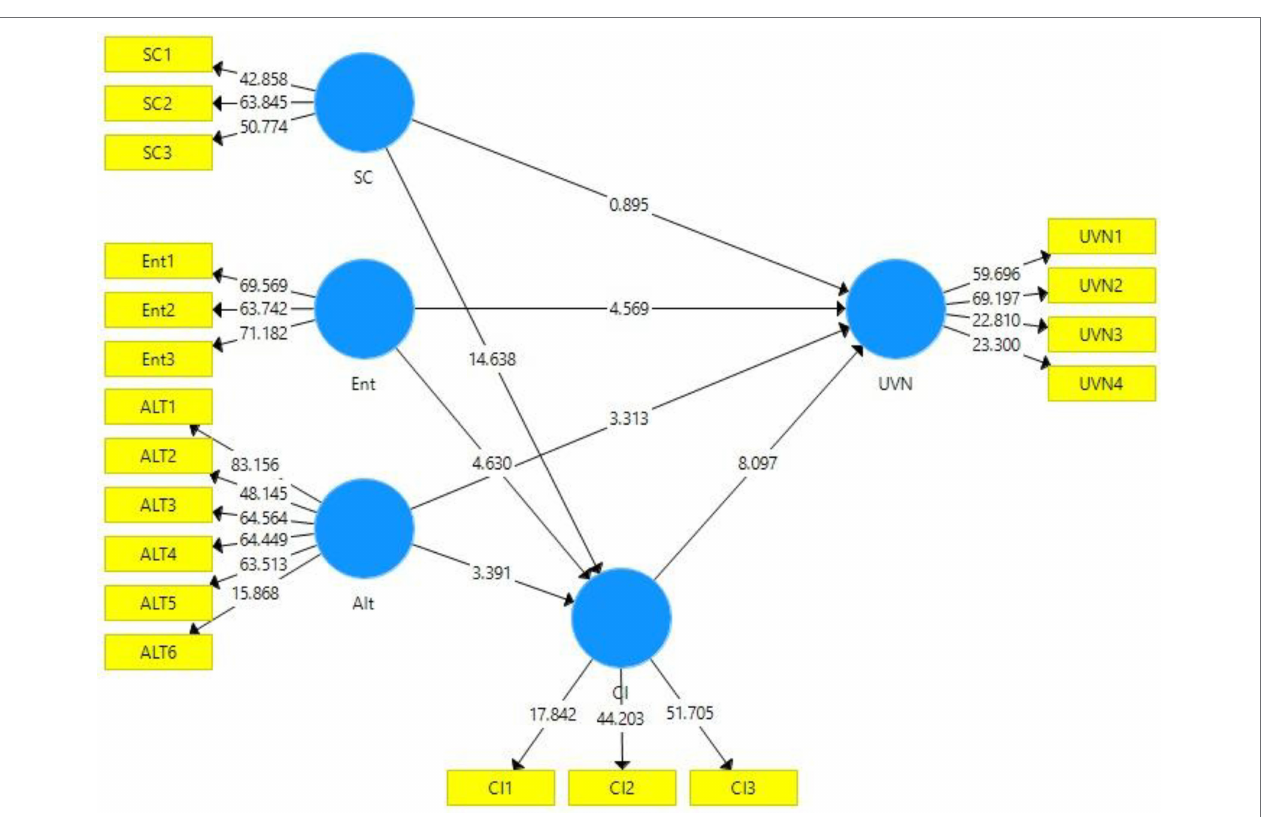
FIGURE 4 | Structural model bootstrapping without moderation. SC, Social Consciousness of Employees; Ent, Entertainment; Alt, Altruism; UVN, Unverified News Sharing; and CI, Corporate